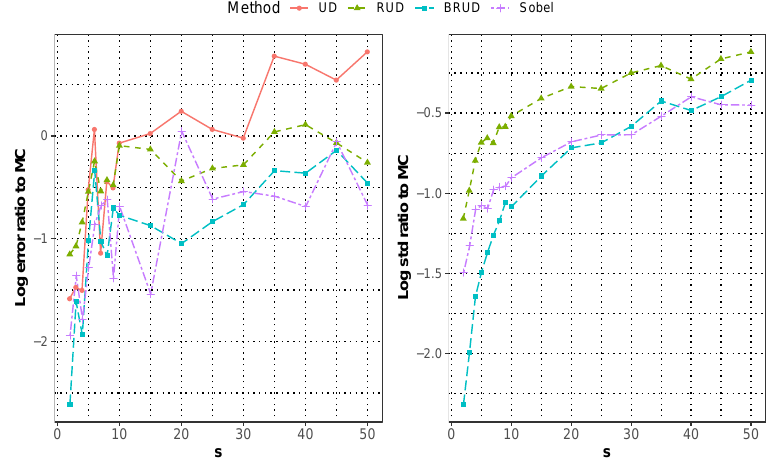
Figure 1. The median approximation error of integration of f 1 ( x ) over all runs for different dimension.